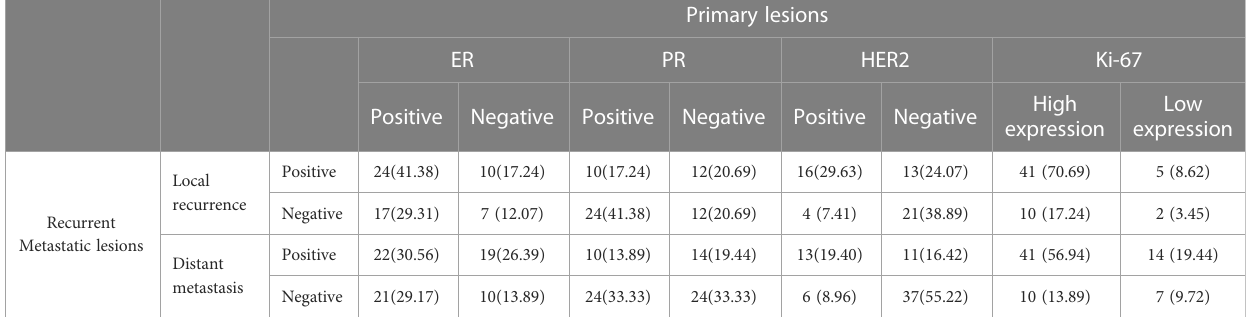
TABLE 2 Expression of immunohistochemical indexes in primary and recurrent metastatic lesions [n